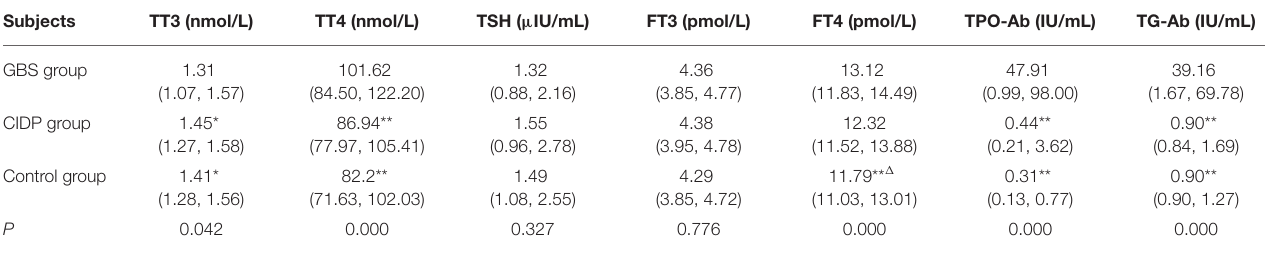
TABLE 2 | Comparison of thyroid function and autoantibodies parameters between GBS and CIDP groups M ( P25 , P75 ). Subjects